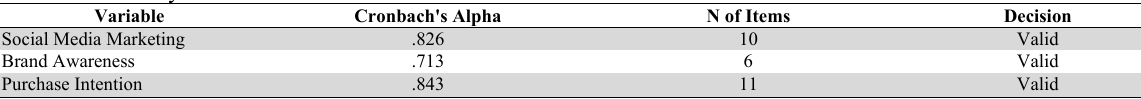
Result of Reliability Test